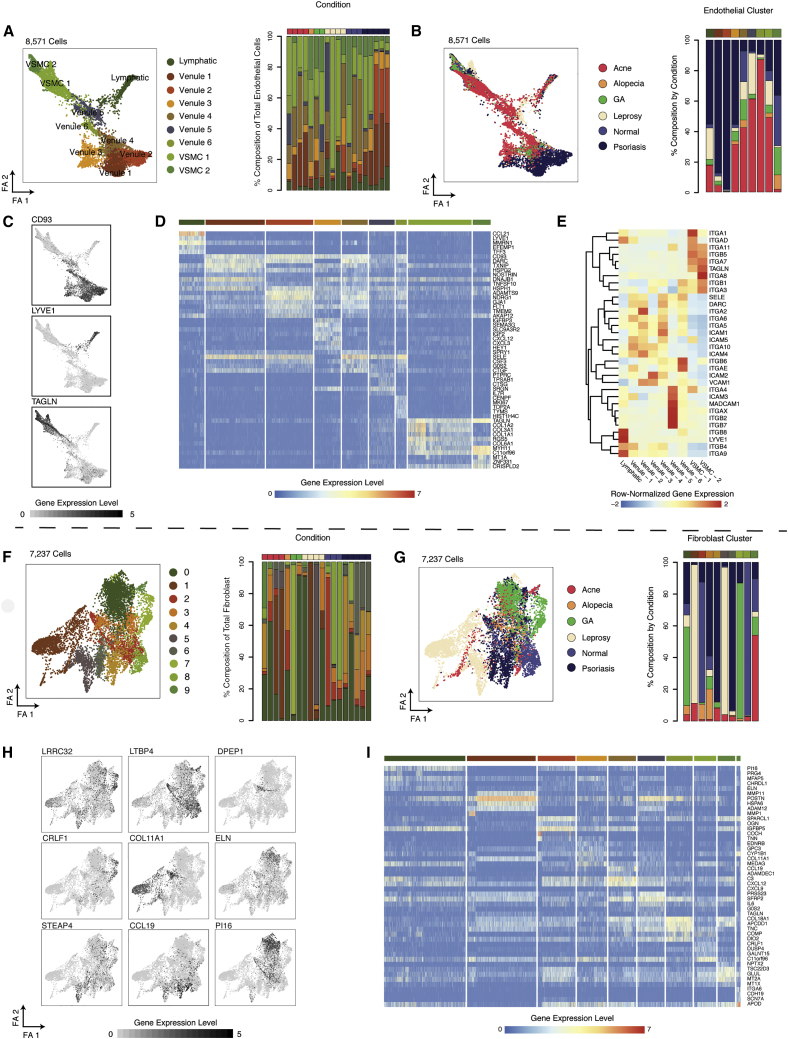
Stromal Cell Diversity(A) Force-directed plots for 8,571 endothelial cells colored by phenotypic sub-cluster (left) and stacked barplot showing the distribution of endothelial phenotypic sub-clusters across samples (right) (Table S3).(B) Force-directed plots for 8,571 endothelial colored by inflammatory skin condition (left) and stacked barplot showing the contribution of each inflammatory skin condition to endothelial phenotypic sub-clusters (right).(C) Force-directed plot colored by normalized expression amounts of genes that mark endothelial cell types: (Left) CD93, venules, (Middle) TAGLN, arterioles, (Right) LYVE1, lymphatics.(D) Heatmap showing patterns of normalized gene expression amounts (log(scaled UMI + 1)) across nine clusters of endothelial cells (Table S3).(E) Heatmap showing row-normalized expression amounts of vascular addressins across phenotypic sub-clusters of endothelial cells.(F) Force-directed plots for 7,237 fibroblasts colored by phenotypic sub-cluster (left) and stacked barplot showing the distribution of fibroblast phenotypic sub-clusters across samples (right) (Table S3).(G) Force-directed plots for 7,237 fibroblasts colored by inflammatory skin condition (left) and stacked barplot showing the contribution of each inflammatory skin condition to fibroblast phenotypic sub-clusters (right).(H) Force-directed graphs highlighting fibroblast cluster-defining genes.(I) Heatmap showing the normalized gene expression levels (log(scaled UMI + 1)) of fibroblast cluster-defining genes (Table S3).